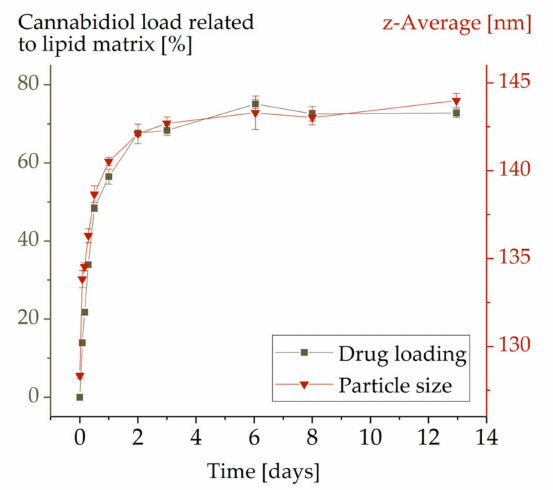
Figure 1. Kinetics of cannabidiol loading in emulsion MCT-P188-120 nm. Error bars represent the standard deviations but are mostly not